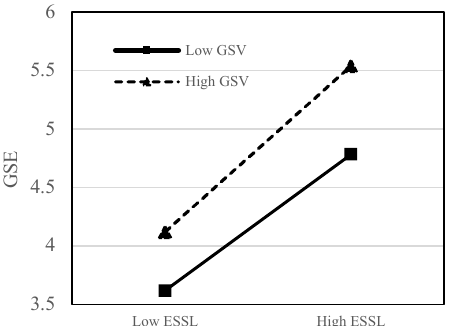
Figure 2. The moderating effect of GSV on the relationship between ESSL and GES.